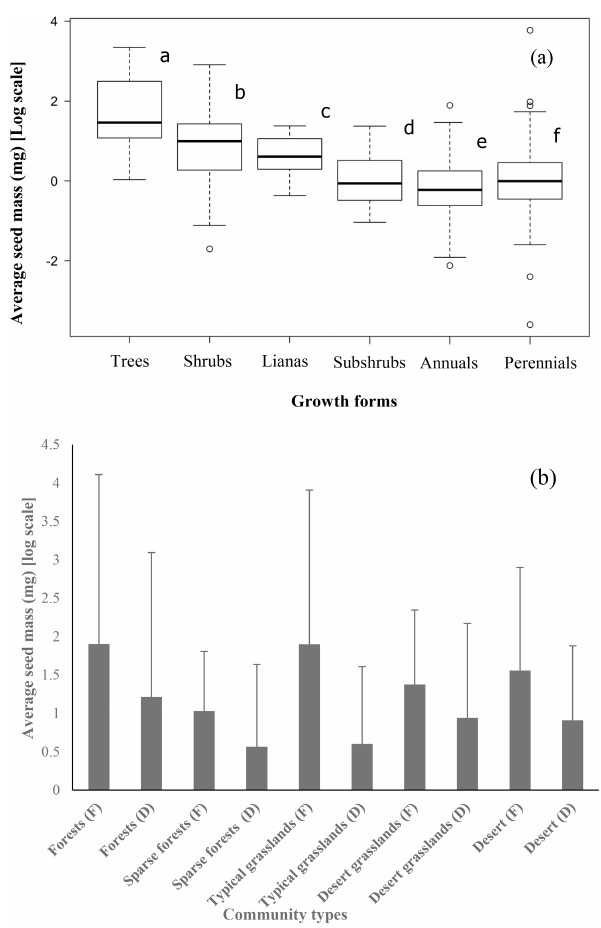
Figure 2. Trees (12 species) have the largest average seed mass, followed by shrubs (65 species), lianas (15 species), subshrubs (20 species), perennial herbs (396 species) and annuals (110 species) (a) (average seed mass bearing different letters are significantly differ- ent at p < 0 . 05). The average seed mass of fleshy fruits is larger than that of dry fruits in each community type (b) (F: fleshy fruits, D: dry fruits).